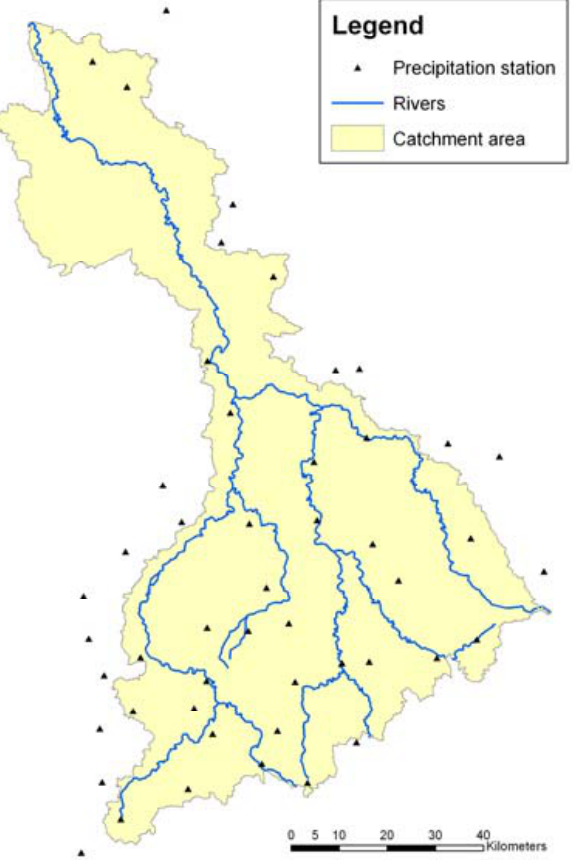
Fig. 2. Locations of the 49 precipitation stations in and around the study Figure 2: Locations of the 49 precipitation stations in and around the study area